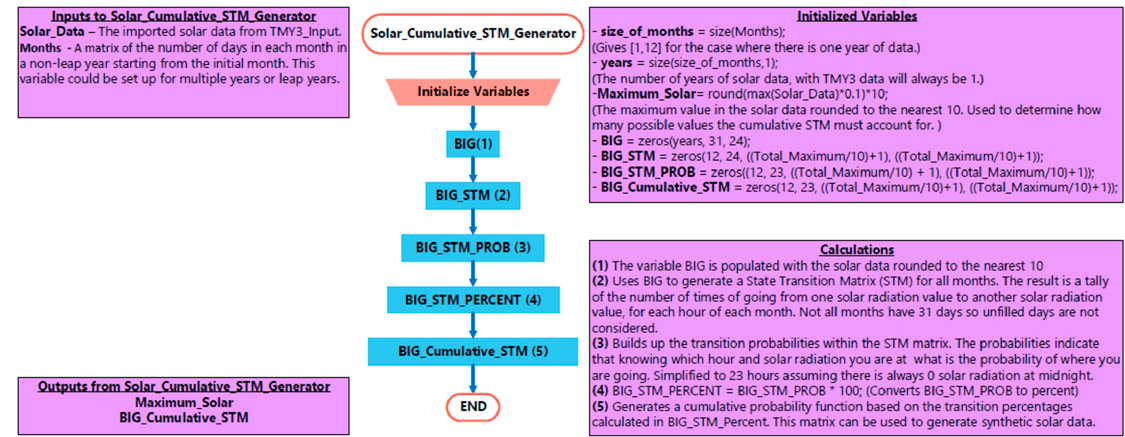
Figure A2. Flowchart explaining “Solar Cumulative STM Generator.m”. Outputs are Maximum Solar and BIG Cumulative STM which are utilized to create solar data in Solar Irradiation Simulator.m.